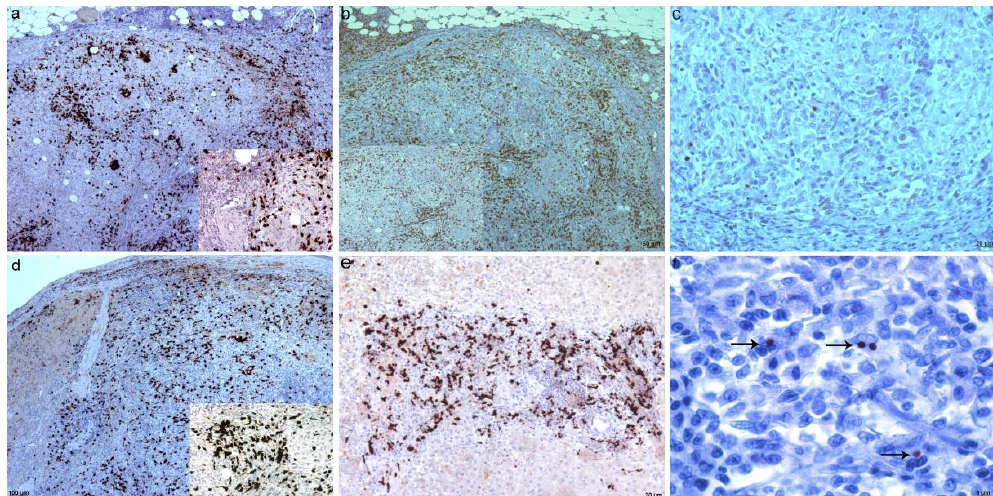
Figure 3. Immunohistochemical findings in dog 1. ( a ) Peritonitis with numerous macrophages forming granulomas and scattered throughout the peritoneum, 50×. Inset: detail of granulomas infiltrated by numerous macrophages (polyclonal antibody against MAC387 antigen), 200×. ( b ) Peritonitis with numerous T lymphocytes irregularly distributed between granulomas, 50×. Inset: detail of T lymphocytes surrounding and infiltrating granulomas (polyclonal antibody against CD3), 100×. ( c ) Scattered B lymphocytes in area with intense inflammation (monoclonal antibody against Pax5 antigen), 200×. ( d ) Granulomatous splenitis with numerous macrophages. 50×. Inset: detail of granulomas infiltrated with macrophages, 200×. ( e ) Granulomatous hepatitis with numerous macrophages (polyclonal antibody against MAC387 antigen), 100×. ( f ) Amastigote forms in inflammatory reaction. Arrows mark brown immunostained parasites (polyclonal antibody against Leishmania ), 630×.